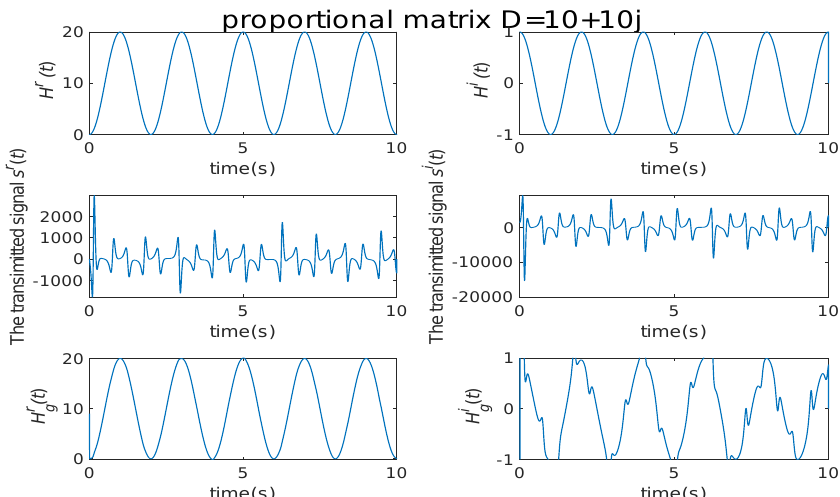
Figure 5. The CMPDFS process without noise when D = 10 + 10 j